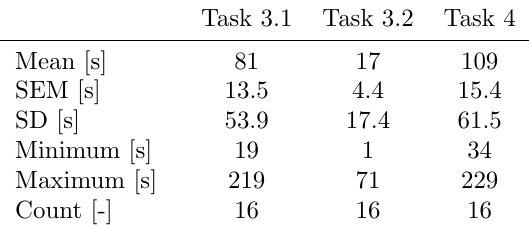
Table 4: Execution time results of FGUI Task 3.1 Task